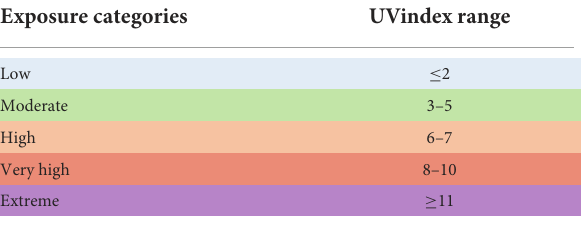
TABLE 1 Ultraviolet radiation exposure categories by WHO UVindex